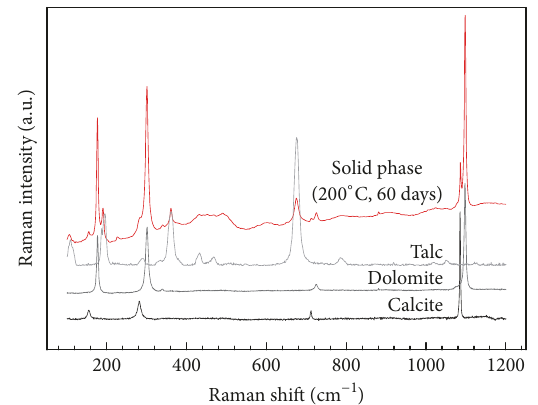
Figure 6: Raman spectrum of solid relicts after heating at 200 ∘ C for 60 days. The reference spectra of dolomite, calcite, and talc were also shown for comparison. The dolomite spectrum was acquired from the sample before heating. The calcite spectrum was acquired from crystalline calcite, and the reference spectrum of talc was cited from an open database hosted by the Department of Geosciences at the Table 2: Variations in the internal pressures of the HPOC contain- ing dolomite and water with experimental duration at 200 ∘